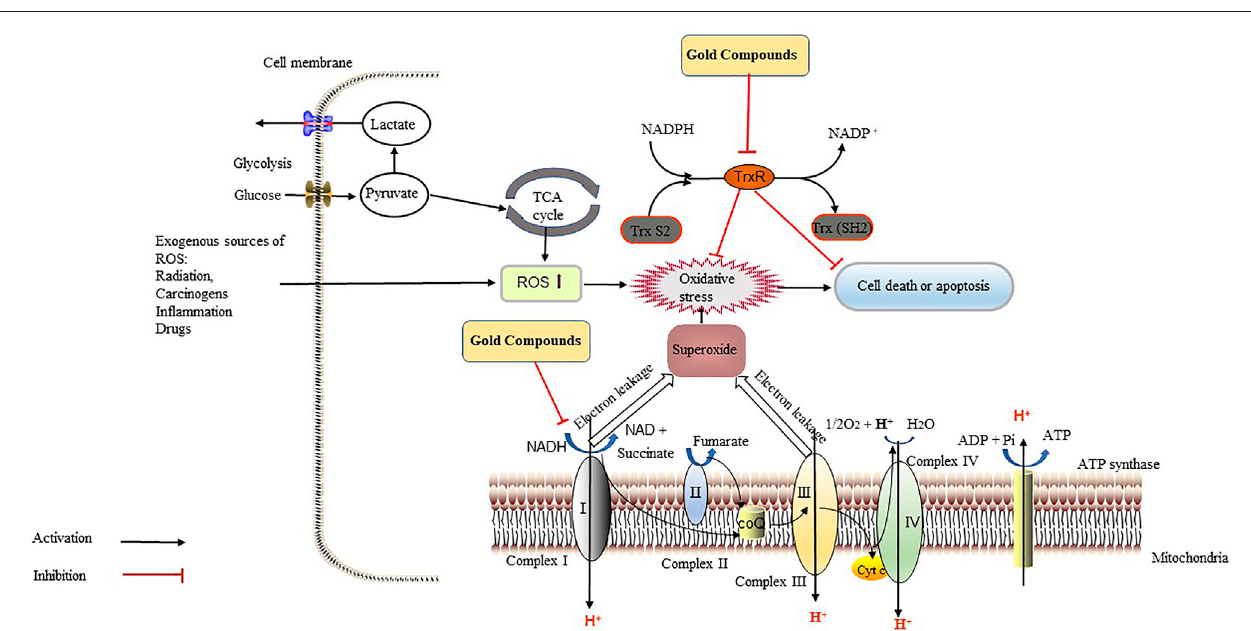
FIGURE 4 | Gold compounds exert anti-tumor effects through the inhibition of thioredoxin reductase (TrxR) and the respiratory chain. TrxR maintains the redox balance in tumor cells, reverses the damage caused by various types of oxidatives stress, accelerates cell division and growth, and increases the ability of tumor cells to resists apoptosis, which all accelerate the metastasis and diffusion of cancer cells. Gold compounds can inhibit the activity of TrxR, leading to the accumulation of reactiveoxygen species (ROS) and oxidative stress in tumor cells, thereby causingtumor cells death. Gold compounds also inhibit the respiratory chaincomplex I, causing intracellular ATP depletion, which inhibits tumor growth. Abbreviations: CoQ, coenzyme Q; Cyt C, cytochrome C; NAD, nicotinamide adenine dinucleotide; NADPH, NAD